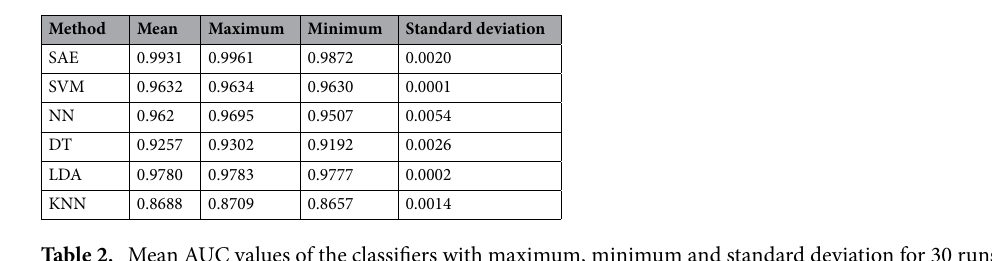
Table 2. Mean AUC values of the classifiers with maximum, minimum and standard deviation for 30